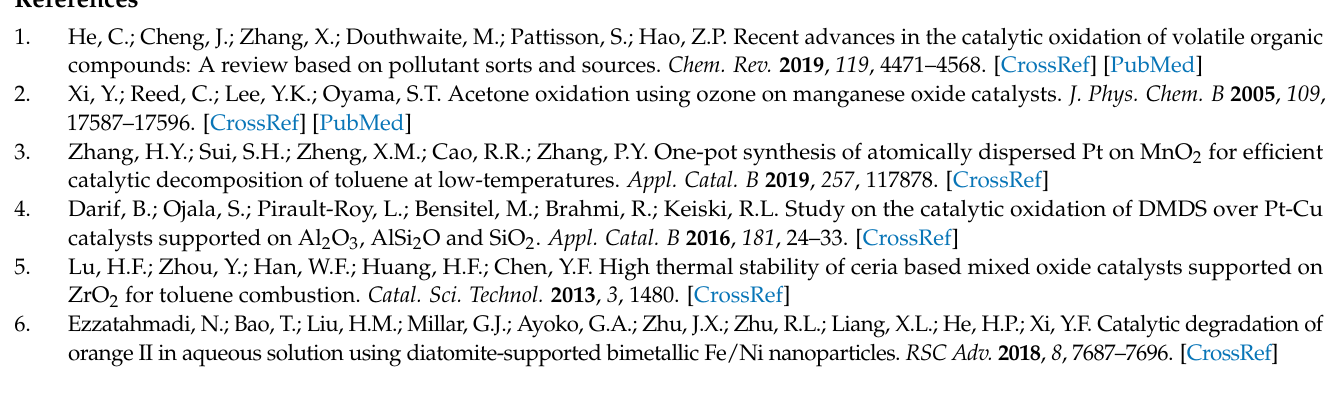
s1: Table S1, Comparison of catalytic activities for ethyl acetate and toluene oxidation of the Pt/CeMnO x /diatomite sample prepared in the present work and various catalysts reported in the literature; Figure S1, Ethyl acetate or toluene conversion as a function of reaction temperature over the Pd/CeMnO x /diatomite and Pt/CeMnO x /diatomite samples at SV = 20,000 mL g − 1 h − 1 ; Figure S2, Ethyl acetate or toluene conversion as a function of reaction temperature over the Pt/CeMnO x /diatomite samples with different Ce/Mn ratios at SV = 20,000 mL g − 1 h − 1 ; Figure S3, Ln k versus inverse temperature over (a) Pt/CeMnO x , (b) Pt/CeMn 2 O x /diatomite, (c) Pt/CeMnO x / diatomite, (d) Pt/CeMn 0.5 O x /diatomite, and (e) Pd/CeMnO x /diatomite for the oxidation of (A) toluene and (B) ethyl acetate at SV = 20,000 mL g − 1 h − 1 ; Figure S4, Deconvoluted reduction peaks in H 2 -TPR profiles of the CeMnO x and CeMnO x /diatomite samples; Figure S5, TGA curves of